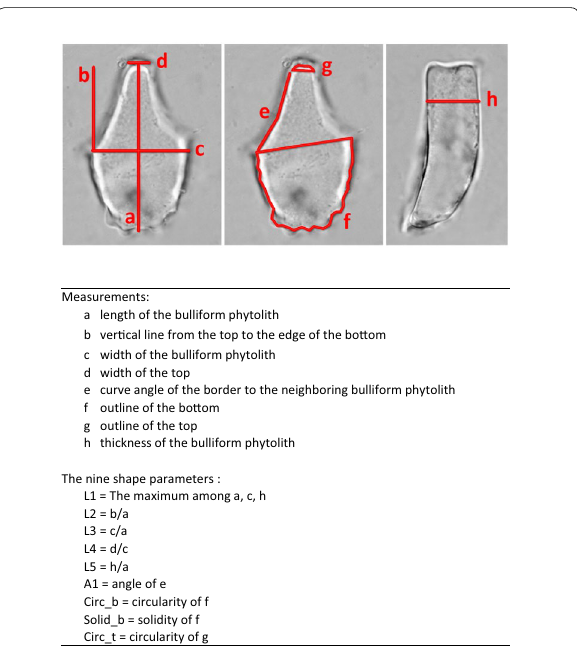
Fig. 1 Measurements and the nine shape parameters of Poaceae bulliform phytoliths. A grain of bulliform phytolith from B. oldhamii is shown as an example. a – g end view, h lateral